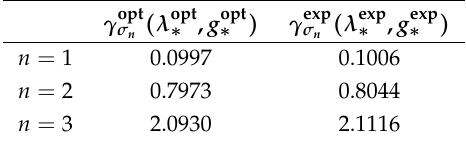
Table 2. Fixed-point values of γ σ in d = 4 for the full-fledged single metric Einstein–Hilbert truncation. n